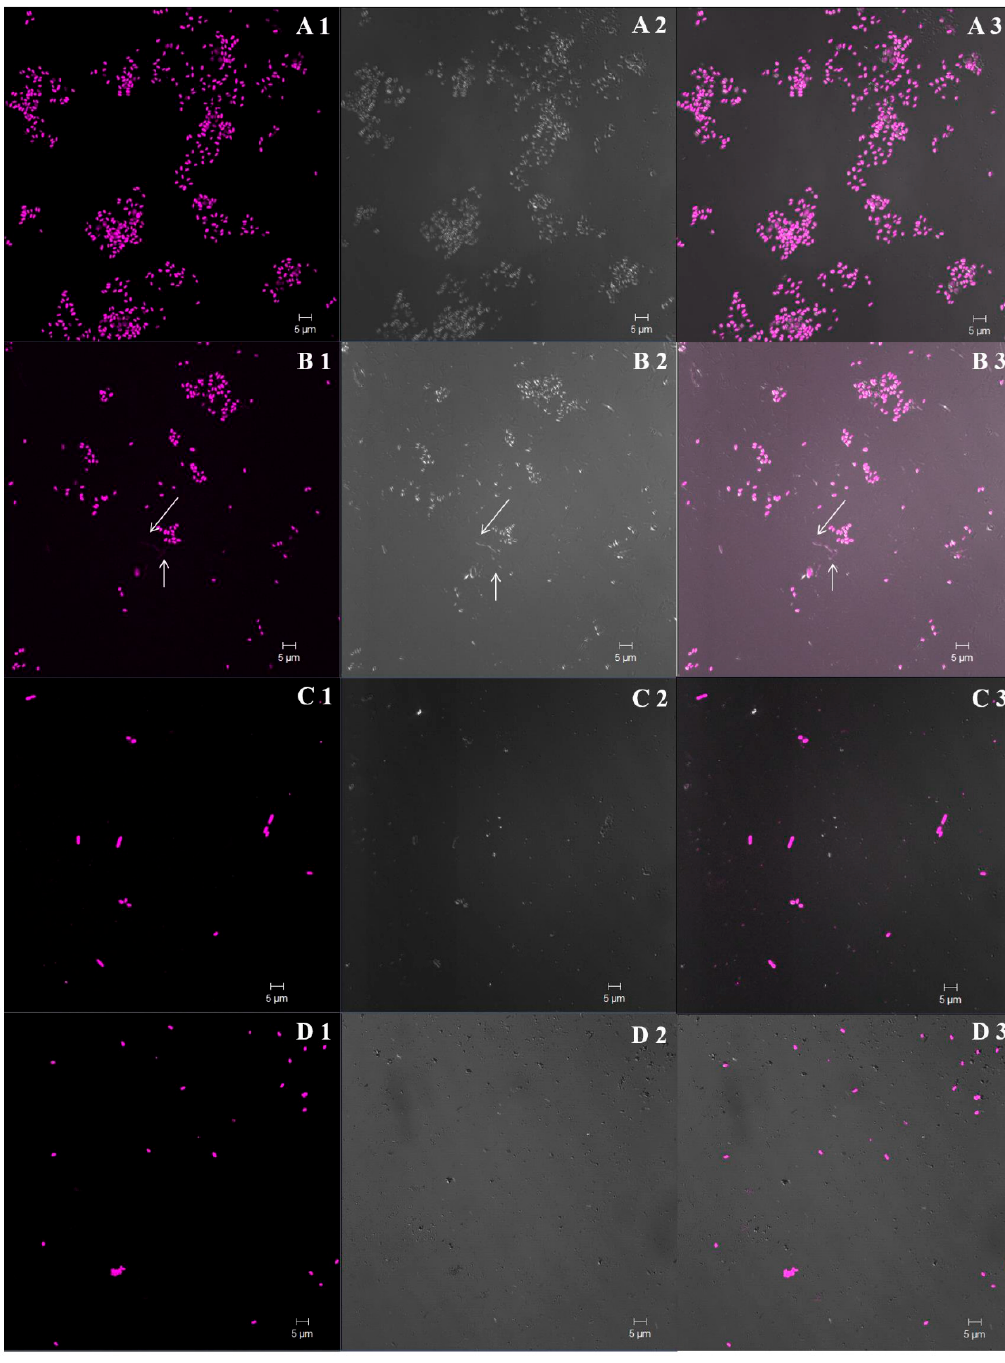
Figure 4. Confocal microscopy images of ( A ) co-culture grown on agarose; ( B ) co-culture on xylan; ( C ) Sde 2-40 on agarose; and ( D ) Sde 2-40 on xylan. The images in the panel indicate ( 1 ) stained cells; ( 2 ) differential interference contrast (DIC) image; and ( 3 ) merged image. Arrows indicate the B. cereus cells. B. cereus cells showing fluorescence are indicated by arrow in co-culture.